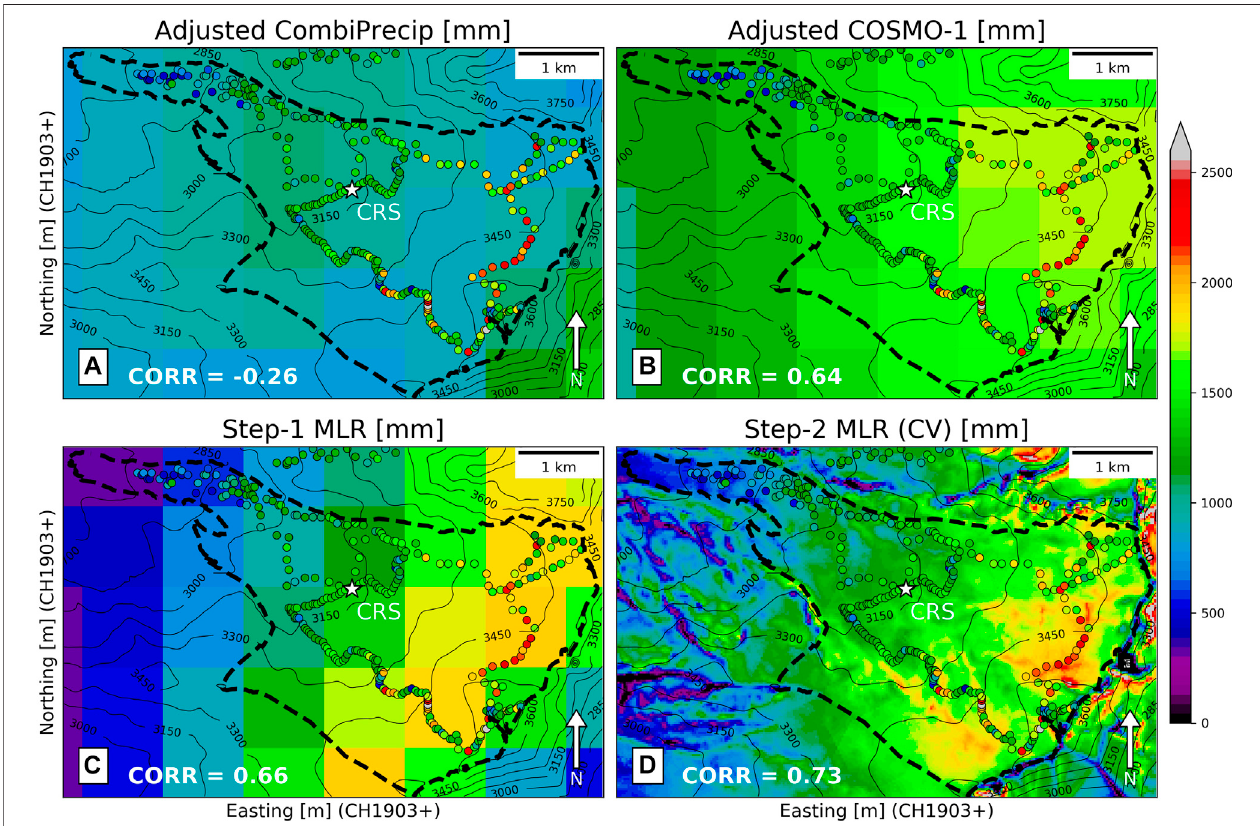
FIGURE 6 | Cumulative precipitation maps (colored grid cells) and in-situ measurements (colored dots) over the Findel glacier at the end of the 2018/19 winter season (24.10.18 – 17.04.19). The glacier outline is shown with the dashed line and elevation contours are shown with solid lines (A , B) show precipitation estimates of adjusted CombiPrecip and adjusted COSMO-1 (C , D) show the model outputs of Step-1 MLR and Step-2 MLR.